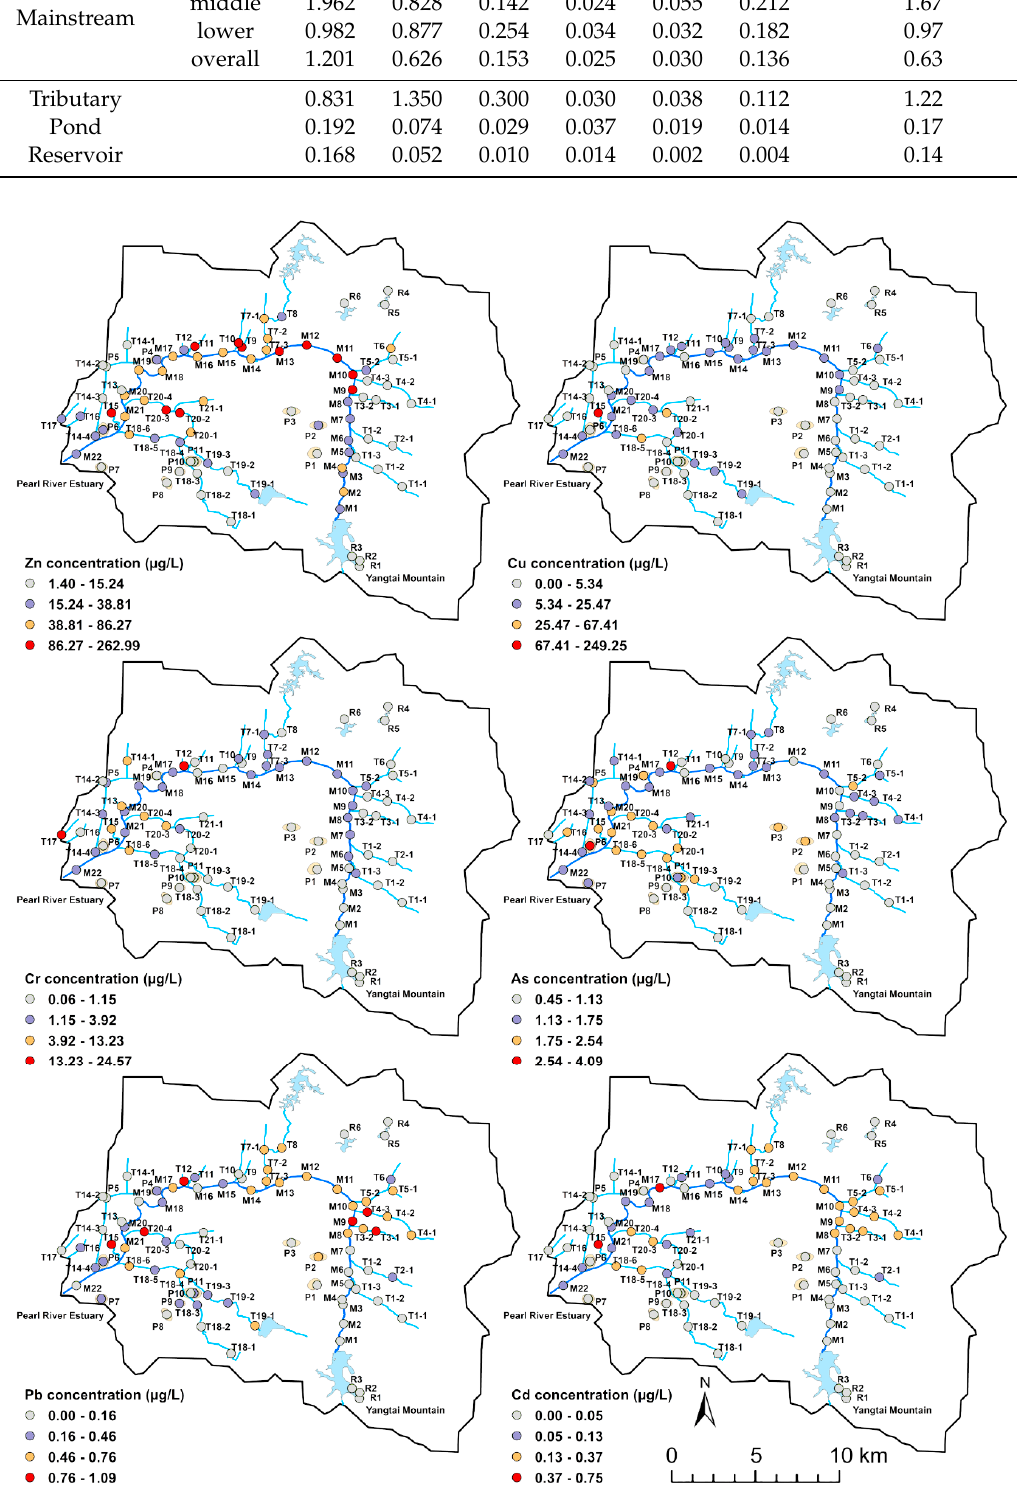
Figure 3. Watershed-scale spatial distribution of metal(loid) concentrations in the Maozhou River Figure3. watershed.